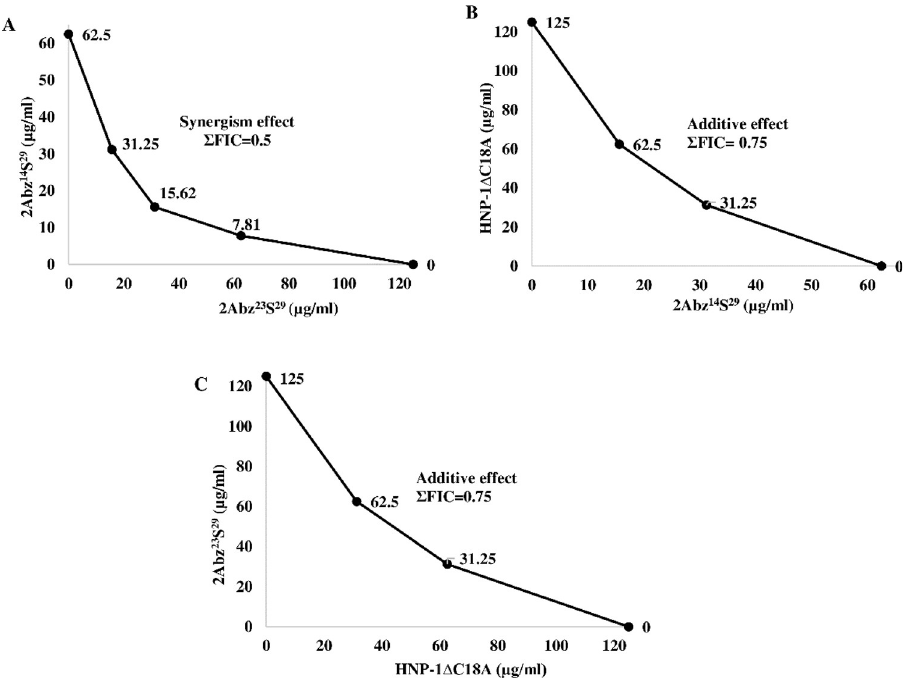
Fig 1. Fractional Inhibitory Concentrations (FICs) plot for 2Abz 14 S 29 , 2Abz 23 S 29 , and HNP-1 Δ C18A combination against CFT073 uropathogenic E . coli . A) The S FIC by the 2Abz 14 S 29 and 2Abz 23 S 29 is (15.62/62.5) + (31.25/125) = 0.5, B) The S FIC by the 2Abz 14 S 29 and HNP-1 Δ C18A is (15.25/62.5) + (62.5/125) = 0.75, C) The S FIC by the 2Abz 23 S 29 and HNP-1 Δ C18A is (15.25/62.5) + (62.5/125) = 0.75, MIC: minimal inhibitory concentration. S FIC �